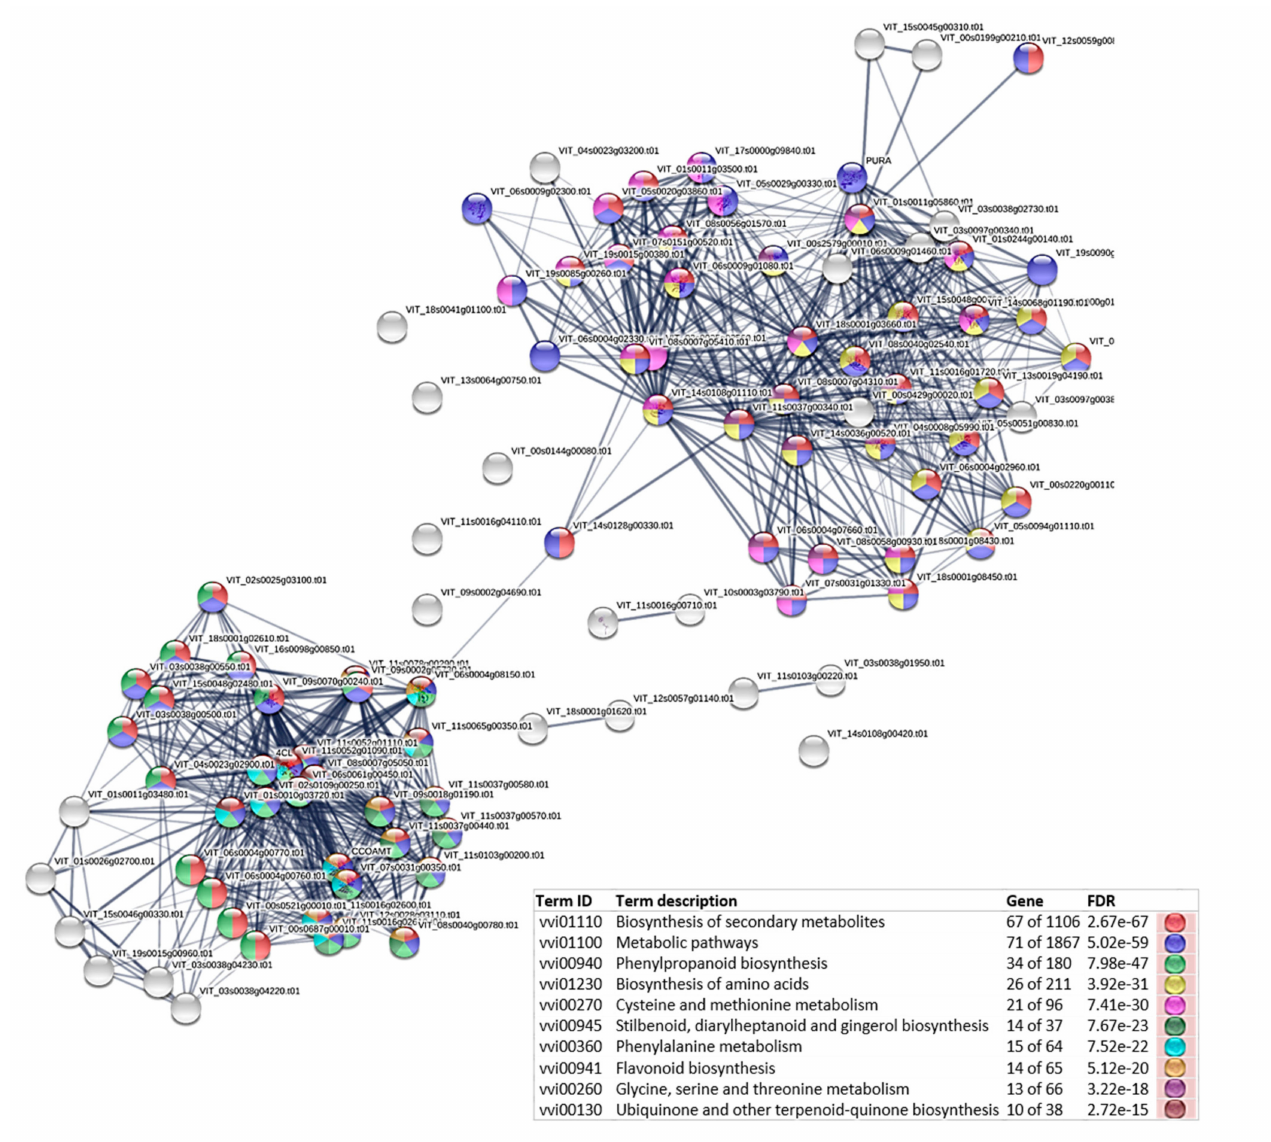
Figure 8. Protein–protein interaction network for flower bud vs. flower comparison. In the protein analysis of the development of the fruits (7 d vs. 50 d), many protein clusters were observed (Figure 9 and Table S6). However, we can highlight the porphyrin and chlorophyll metabolism, biosynthesis of secondary metabolites, photosynthesis or cysteine and methionine metabolism being all of those involved in the early growth of fruit. According to the comparisons between 7 d vs. 120 d or 7 d vs. 160 d, we observed that other physiological mechanisms were involved in the subsequent fruit development including RNA polymerase, pyrimidine and purine metabolism, basal transcription factors or nucleotide excision repair (Figures S11 and